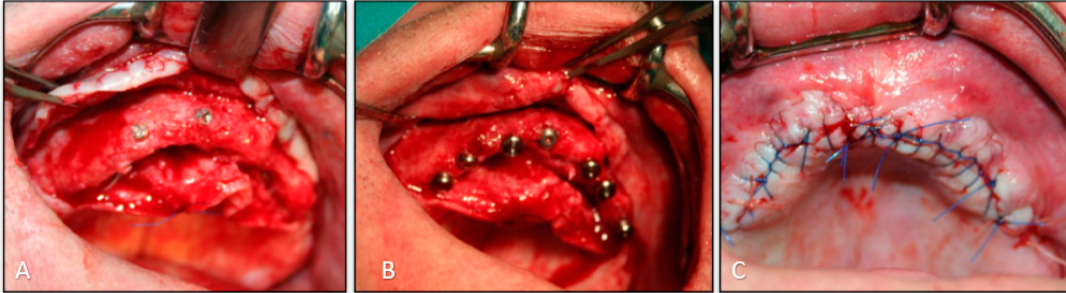
Figure 8. Surgical implants placement. ( A ) Bone quality after the re-opening, ( B ) positioning of seven implants and ( C ) suture of the soft tissue .